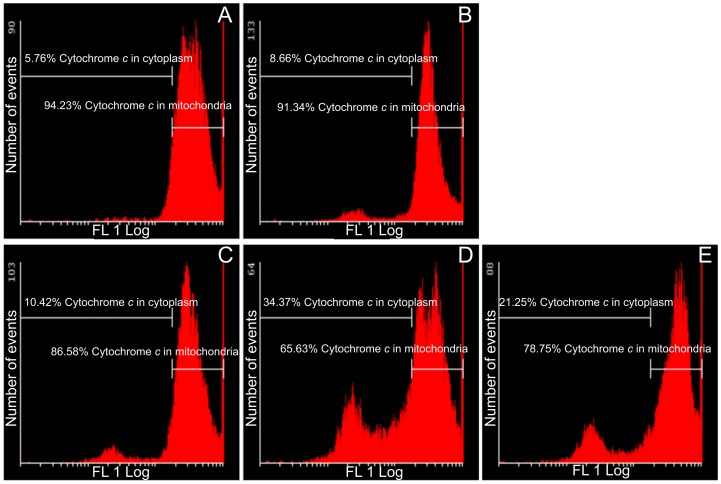
Assay demonstrating cytochrome c release in HeLa cells.Flow cytometry was used to show the effects of these compounds on cytochrome c release from the mitochondria into the cytoplasm in HeLa cells. Vehicle-treated control cells (A), 2-methoxyestradiol-bis-sulphamate-treated cells (B), ESE-16-treated cells (C), ESE-15-one-treated cells (D) and EMBS-treated cells (E) following 24 h of exposure. Cytochrome c release was evident in all three compound-treated cells when compared to the vehicle-treated cells.